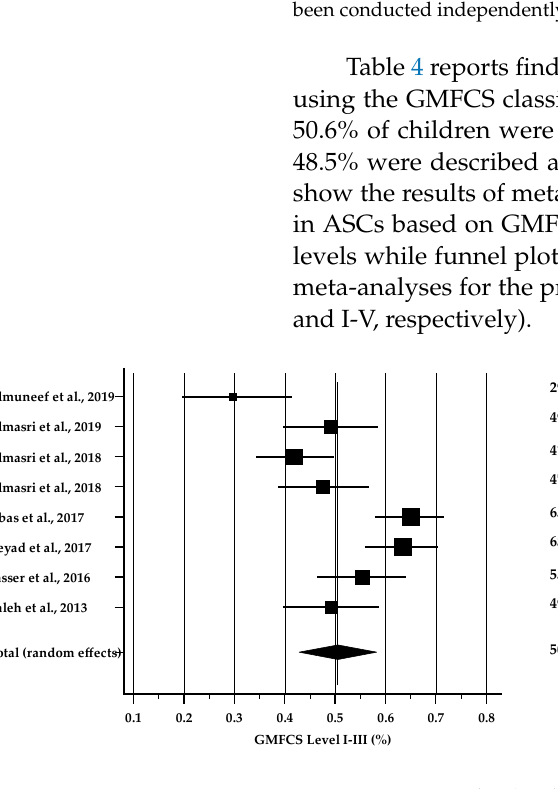
Figure 3. Forest plot (to the left) shows the pooled estimates % of GMFCS level I-III among children and adolescents with CP in ASCs. Assessment of publication bias by Funnel plot (to the right) shows individual study estimates against corresponding standard errors (Kendall’s Tau = − 0.5000, p = 0.0833). I 2 suggests considerable heterogeneity between studies.